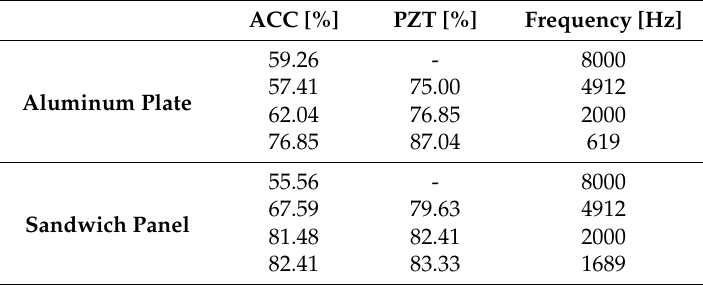
Table A1. Sequence accuracy overview.